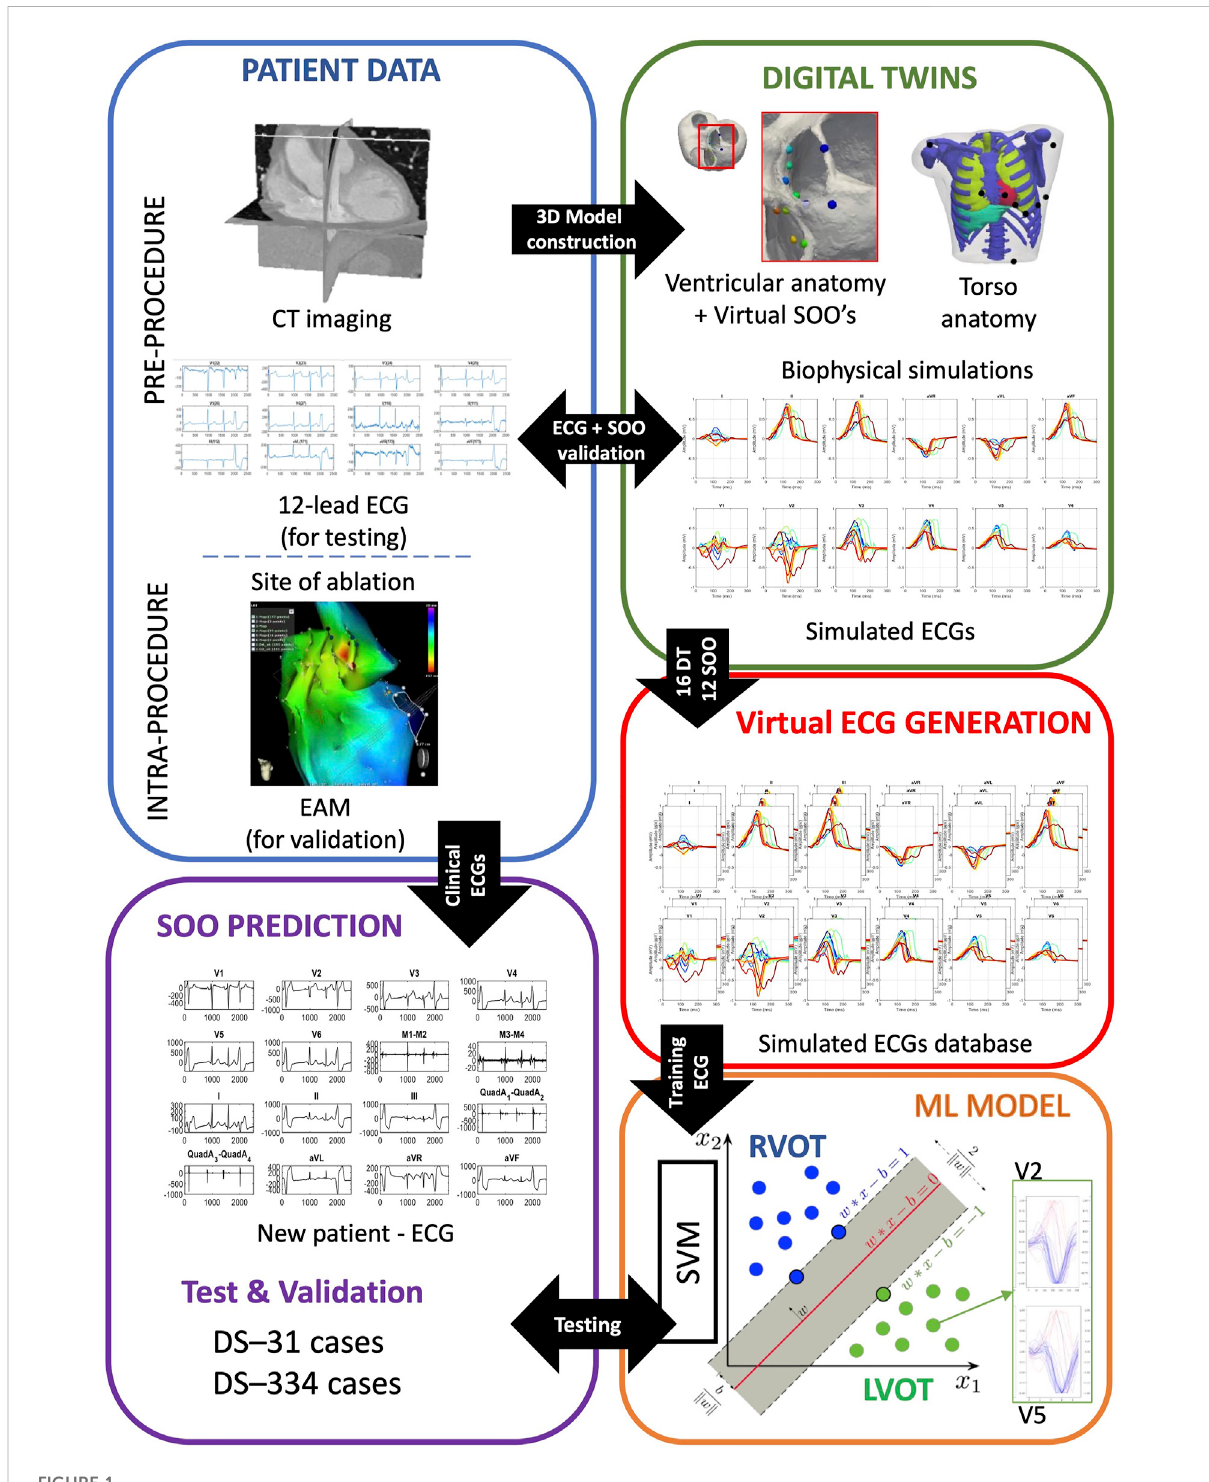
FIGURE 1 Scheme of the proposed methodology. Patient data was used to build ventricular digital twins for the 16 patients. Biophysical simulations were run in thedifferent anatomies, using 12 differentsitesof origin (SOO), to generate a database of 12-lead electrocardiograms (ECGs). The database of simulated ECGs was fi nally used to train a ML algorithm to predict the SOO (Right ventricle out fl ow tract (RVOT) vs. Left ventricle out fl ow tract (LVOT)) of real patients ECGs from two different clinical datasets (DS-334 and DS-31). Abbreviations used in the image: CT: computed tomography; EAM: electroanatomical mapping; ML: machine learning; SVM: support vector